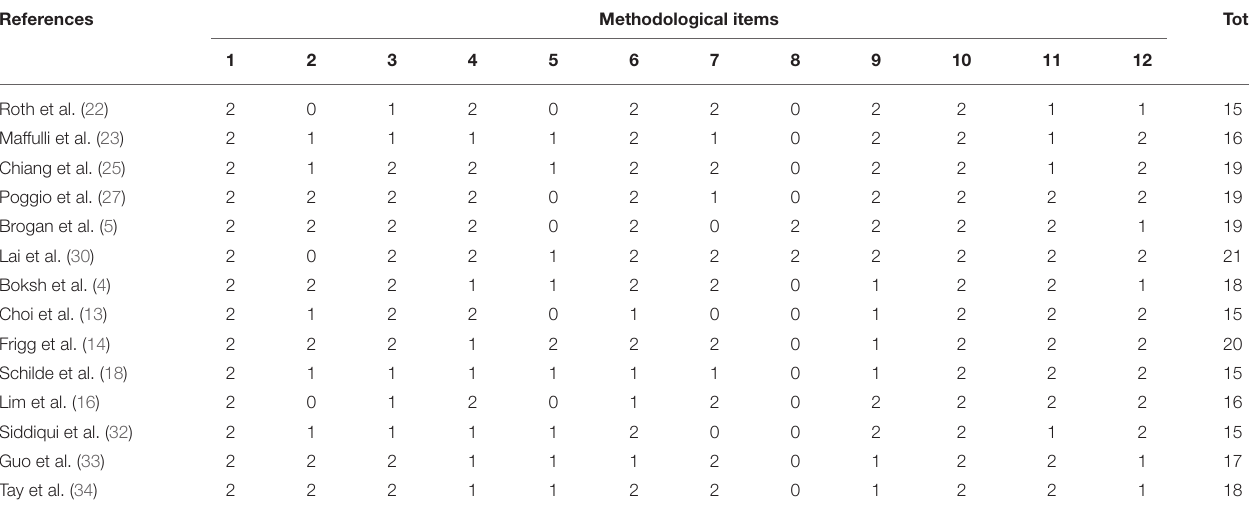
TABLE 2 | MINORS score for each study to assess methodological